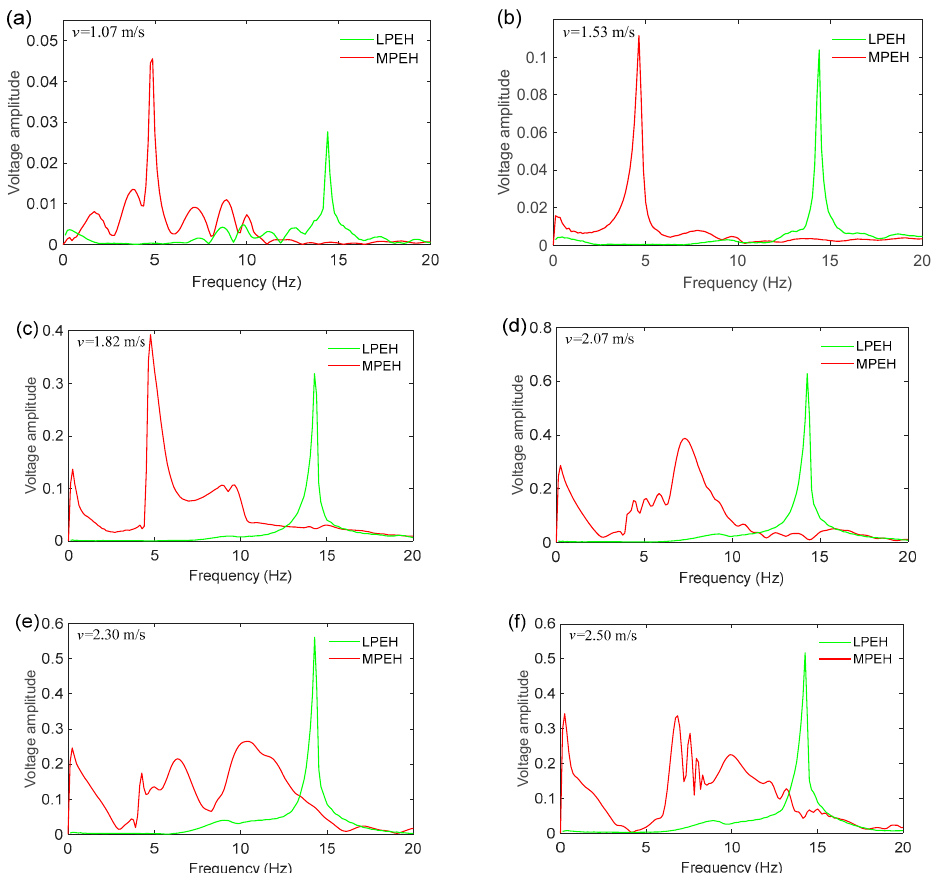
Figure 11. Frequency spectra of the output voltage for a vehicle travelling on and leaving the bridge: ( a ) v = 1.07 m/s, ( b ) v = 1.53 m/s, ( c ) v = 1.82 m/s, ( d ) v = 2.07 m/s, ( e ) v = 2.30 m/s and ( f ) v = 2.50 m/s.